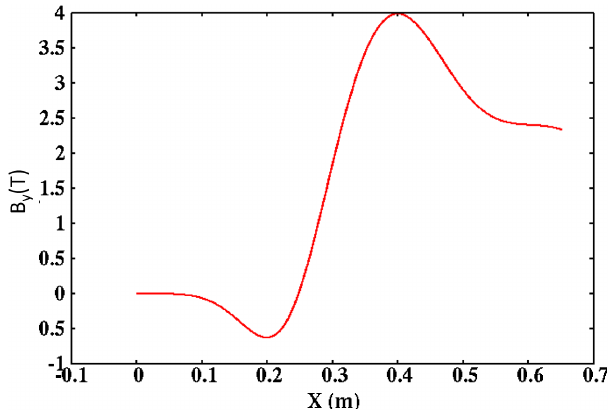
FIG. 10. Vertical magnetic field middle plane